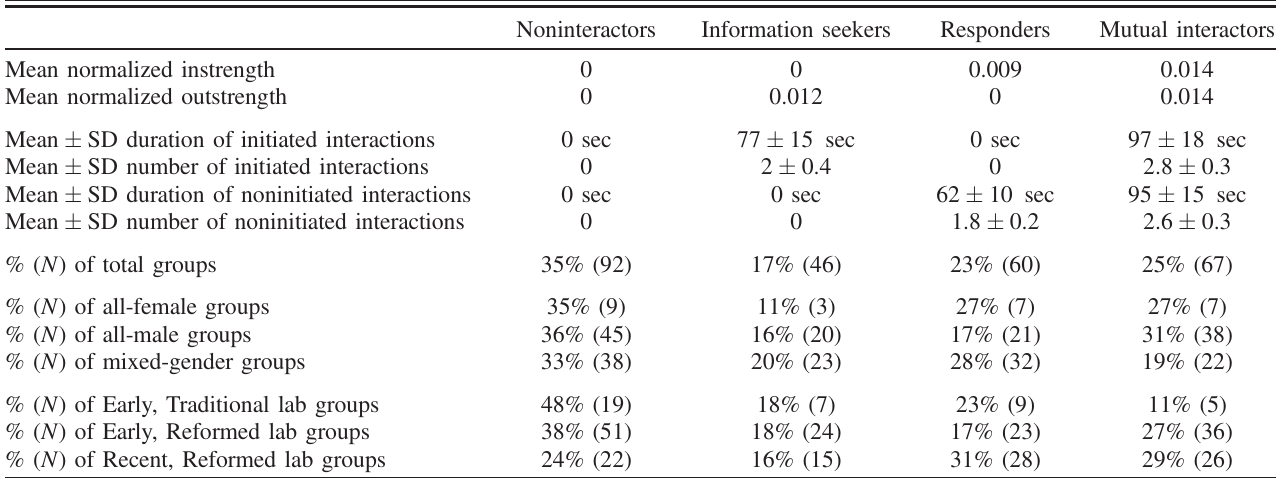
TABLE VI. Summary of social role analysis including each role ’ s mean centrality measures, mean durations and numbers of interactions, and number of groups of each gender composition and lab curriculum.